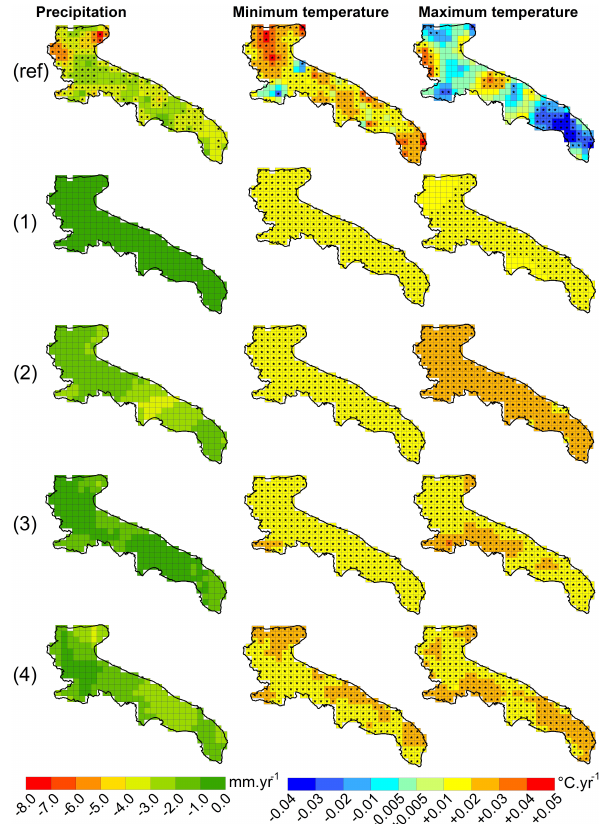
Fig. 8. Spatial distribution of Sen’s slopes resulting from each data processing for annual cumulated precipitation, minimum tempera- ture and maximum temperature. Grid boxes marked with stars are those in which the estimated trend is statistically